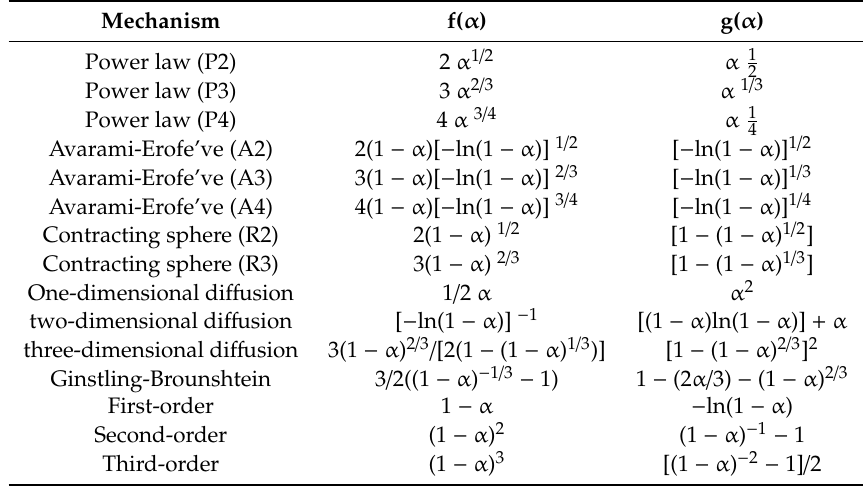
Table 1. Overview of typical reaction models for global conversion based models in solid-phase degradation; f: di ff erential; g: integrated cf. Equation (9)